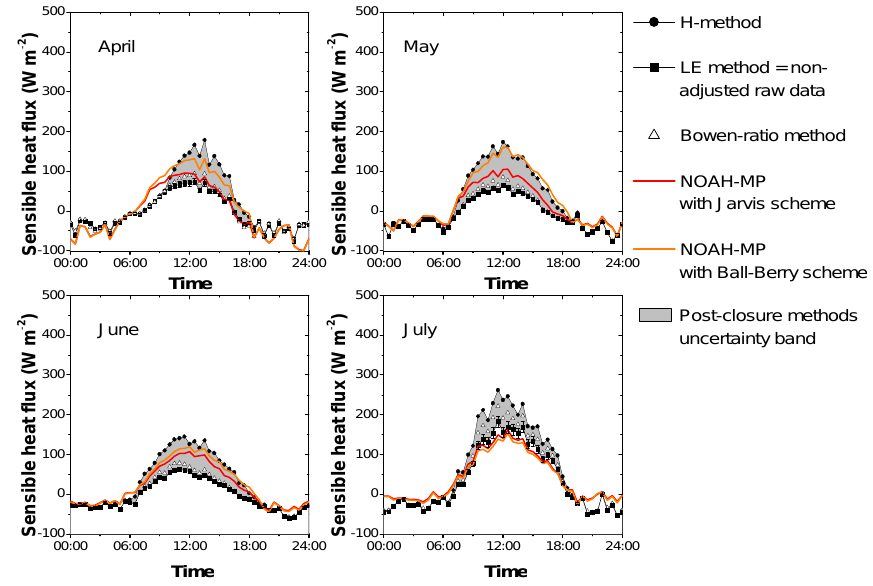
Figure 10. Measured and simulated monthly average diurnal cycles of sensible heat flux over a winter wheat stand in southwest Germany. For modelling, the NOAH-MP land surface model was used in two configurations. The stomatal resistance was computed either with the empirical Jarvis scheme or the photosynthesis-based Ball–Berry scheme. The grey band shows the post-closure methods uncertainty band (PUB) computed as the difference between sensible heat ( H )- and latent heat (LE)-adjusted fluxes. The error bars indicate the random measurement error. In some cases, the error bars are smaller than the size of the symbol and therefore not